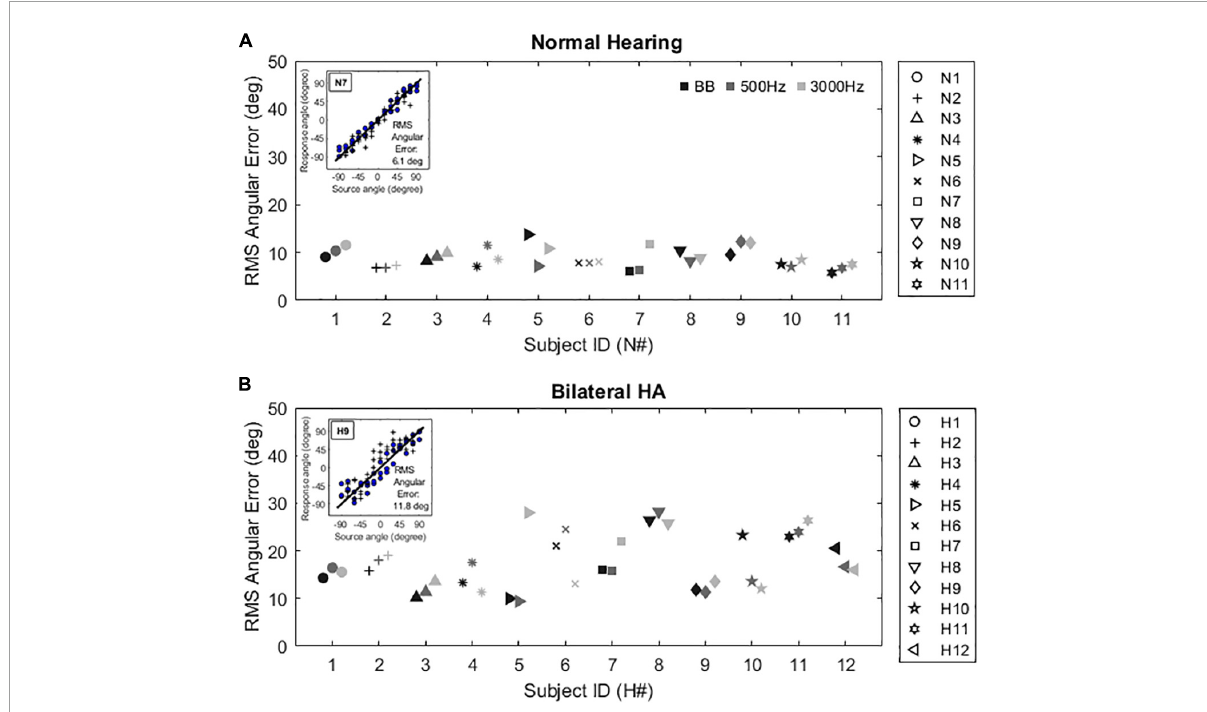
FIGURE6 Individual localization acuity results with three different stimuli (BB: broadband, 500 Hz: band-passed noises centered at 500 Hz, 3000 Hz: band-passed noises centered at 3000 Hz) for NH listeners (A) and bilateral HA users (B) . A sample subject response inset within each panel illustrates the mean root mean square (RMS) angular error calculated by the difference between the perfect localization (diagonal line) and the listener’s response (symbols) angles. The circle and plus symbols indicate the subject’s responses to any given source locations in the front and rear source fields,